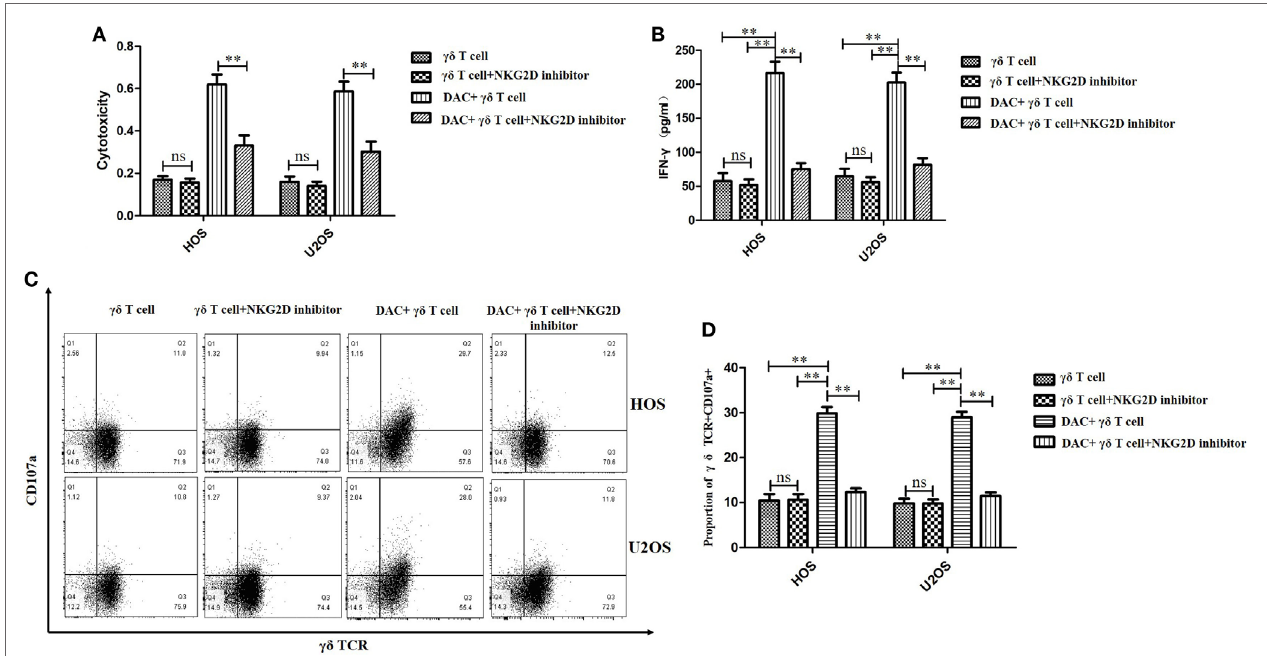
FigUre 5 | Decitabine (DAC) enhanced susceptibility of osteosarcoma (OS) cells to γδ T cell-mediated cytotoxicity via NKG2DL–natural killer group 2D (NKG2D) axis. Expanded γδ T cells were cocultured with OS cells for 4 h at an effector/target ratio of 5:1. (a) γδ T cells’ cytotoxicity on OS cells pretreated with DAC (5 µM) or phosphate-buffered saline for 3 days in the presence or absence of anti-NKG2D blocking antibodies (10 µg/mL) was determined by MTT assays. (B) Supernatants of (a) were harvested and assayed for interferon (IFN)- γ using a IFN- γ enzyme-linked immunosorbent assay kit. (c,D) Cell-surface expression of CD107a on γδ T cells was measured by flow cytometry and quantified by percent of γδ TCR + CD107a + T cells. For (a,B,D) , samples were run in triplicates. Error bars show standard deviation among the replicates ( γδ T cell: tumor cell = 5:1; ns refers to no significance; ** P <